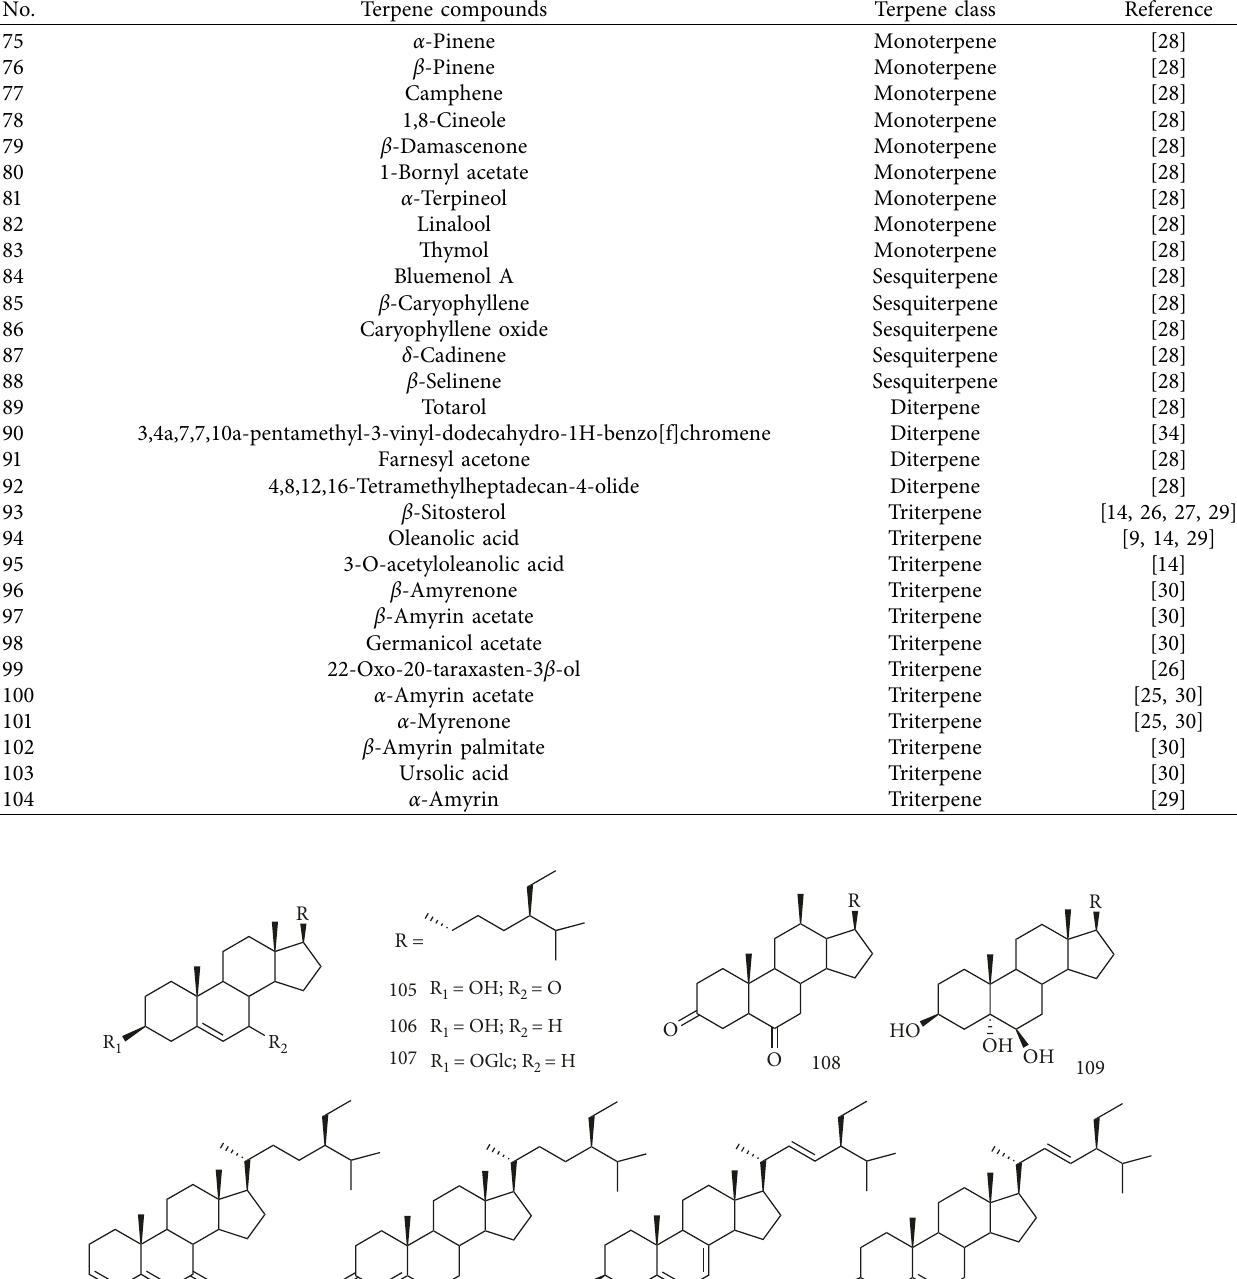
Table 3: Terpenes isolated from F. tikoua Bur.